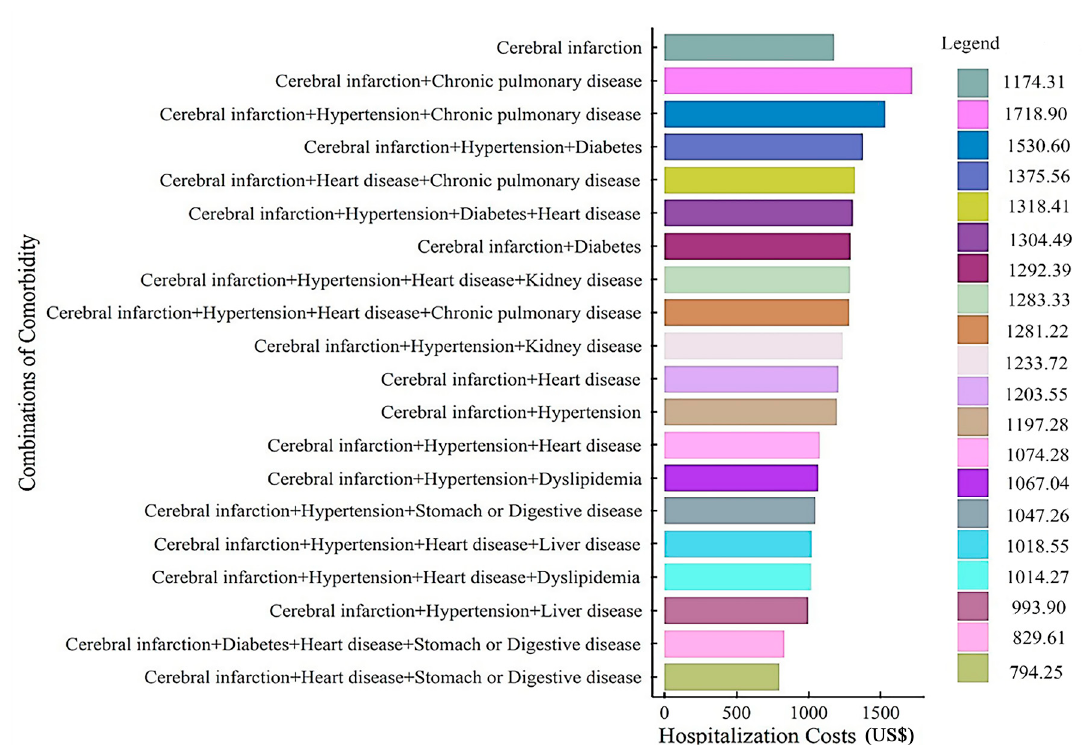
Figure 1. Status of hospitalization costs for different combinations of comorbidities with cerebral infarction.